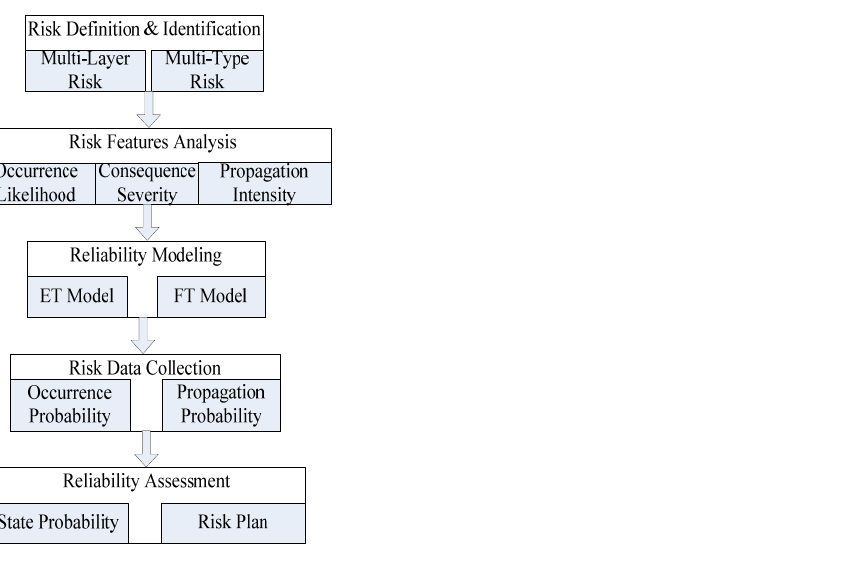
Figure 1. Framework of the space station configuration reliability assessment.